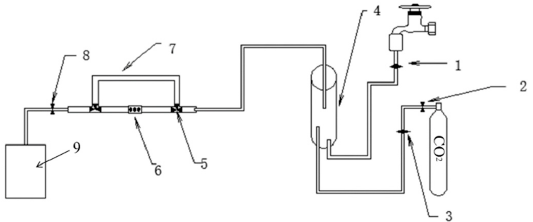
Figure 1. The sketch of the self-designed corrosion experimental platform. 1, liquid flow meter; 2, gas pressure gauge; 3, gas flow meter; 4, mixer; 5, three-way value; 6, test section; 7, bypass; 8, value; 9, tank.